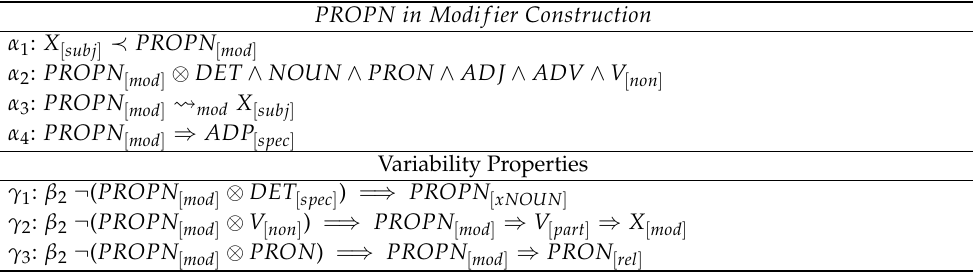
Table A5. PROPN in modifier construction.